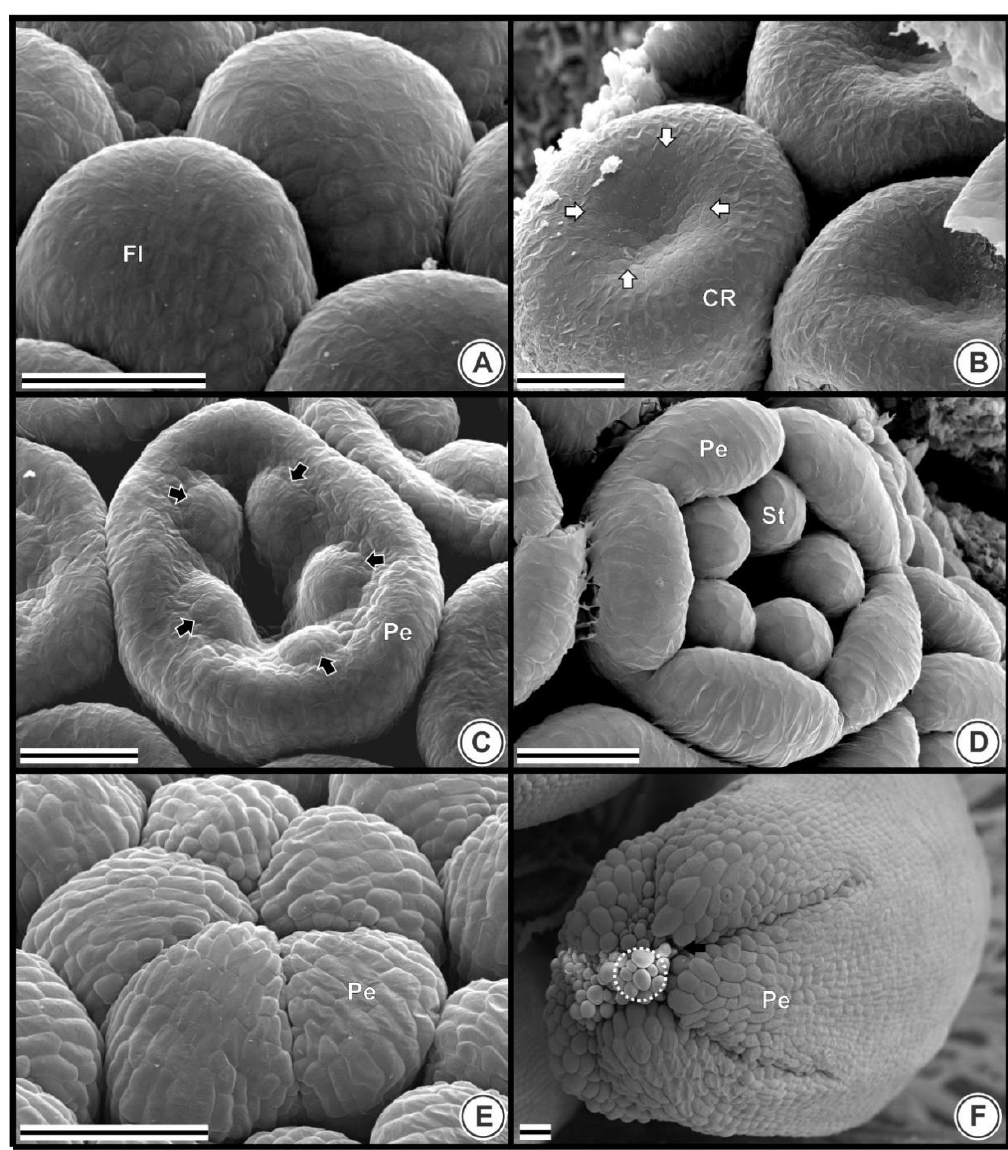
Figure 4. Flower organogenesis in Taraxacum kok-saghyz (scanning electron microscopy from 5 to 33 days after germination). ( A ) Round-shaped; ( B ) Center concavity (white arrow) and corolla ring (CR) primordium; ( C ) Petals and stamens primordia (black arrows); ( D ) Enlarged petals and stamens; ( E ) Petals enclosing the androecium: corolla lobes touching each other; ( F ) Corolla lobes bend towards the floral apex, approach each other until they meet at their margins where they interlock by epidermal cells (white circle). Scale bars: 50 μm. Abbreviations: Co, corolla; CR, corolla ring, Fl, flowers; Pe, petals; St, stamens.